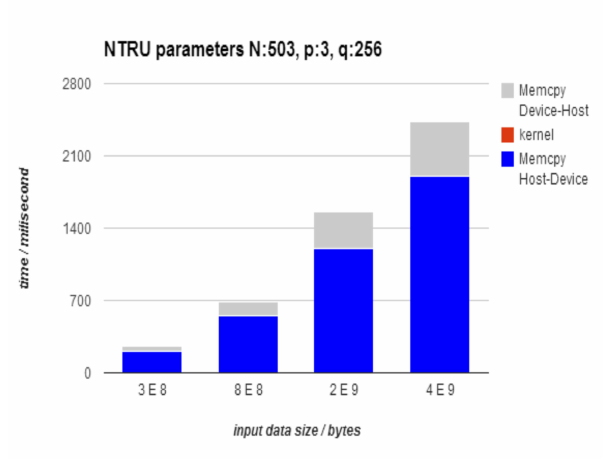
Fig. 8. Execution Breakdown of Single GPU